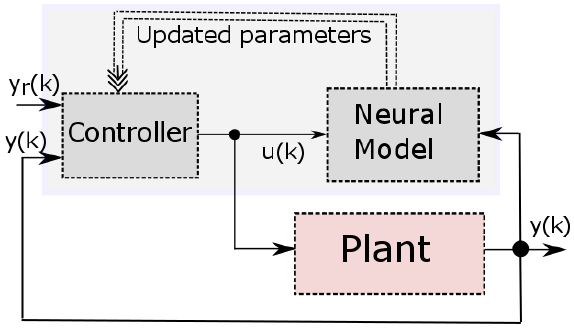
Fig. 3. The control scheme for the estimation of the weights using an